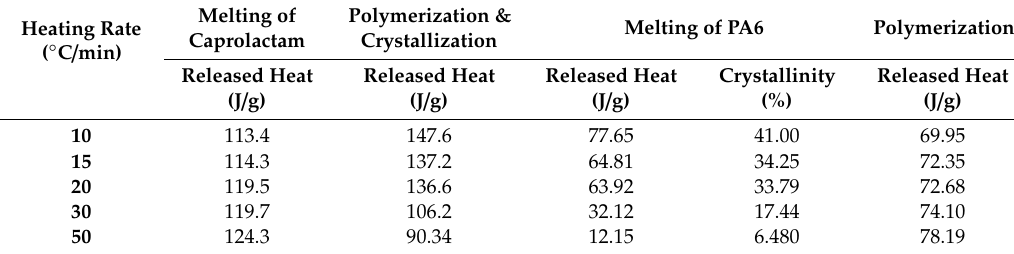
Table 1. Values of released heat during the heating